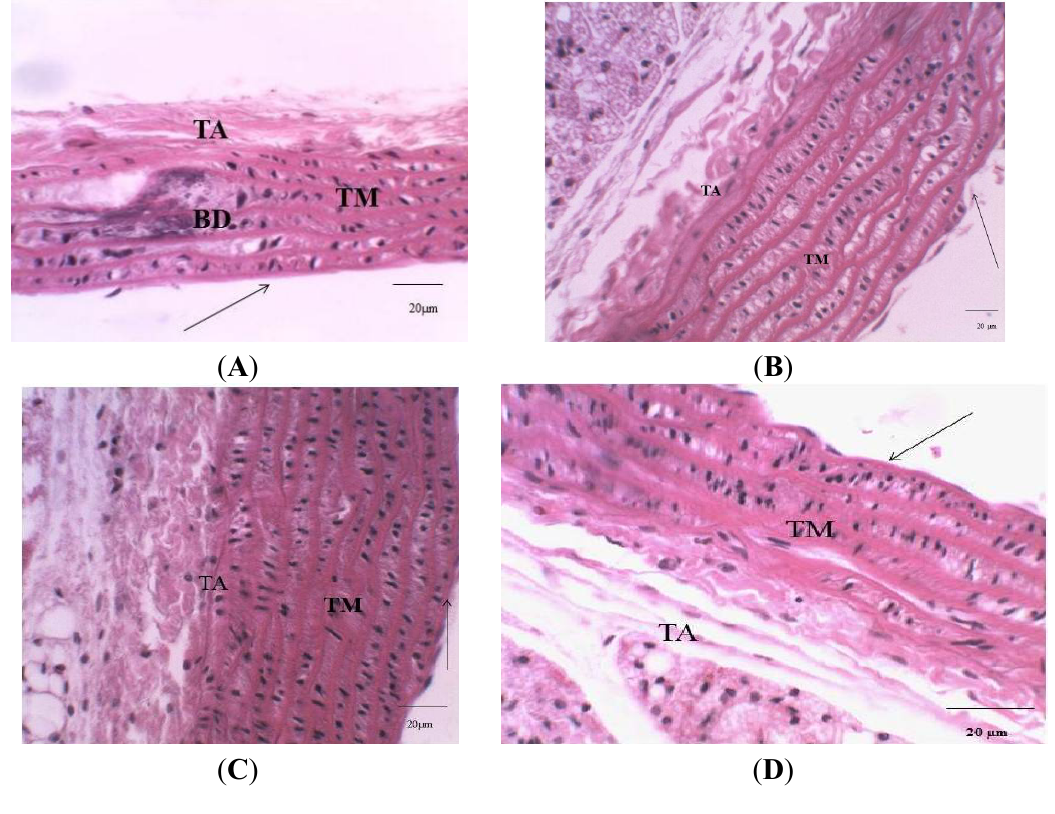
Figure 3. Photomicrograph of rat aorta. ( A ) The aorta of atherogenic rat; ( B ) Control aorta of rat; ( C ) The aorta of (atherogenic diet +500 mg/kg of RTV) rat; ( D ) The aorta of (atherogenic diet + 30 mg/kg of atorvastatin) rat. Showing straight tunica intimae (thin- dark arrow); Tunica media (TM) with elastic fibers, basophilic changes (BD) and tunica adventitia (TA). Scale bar: 20 μ m, H & E stain, 400×